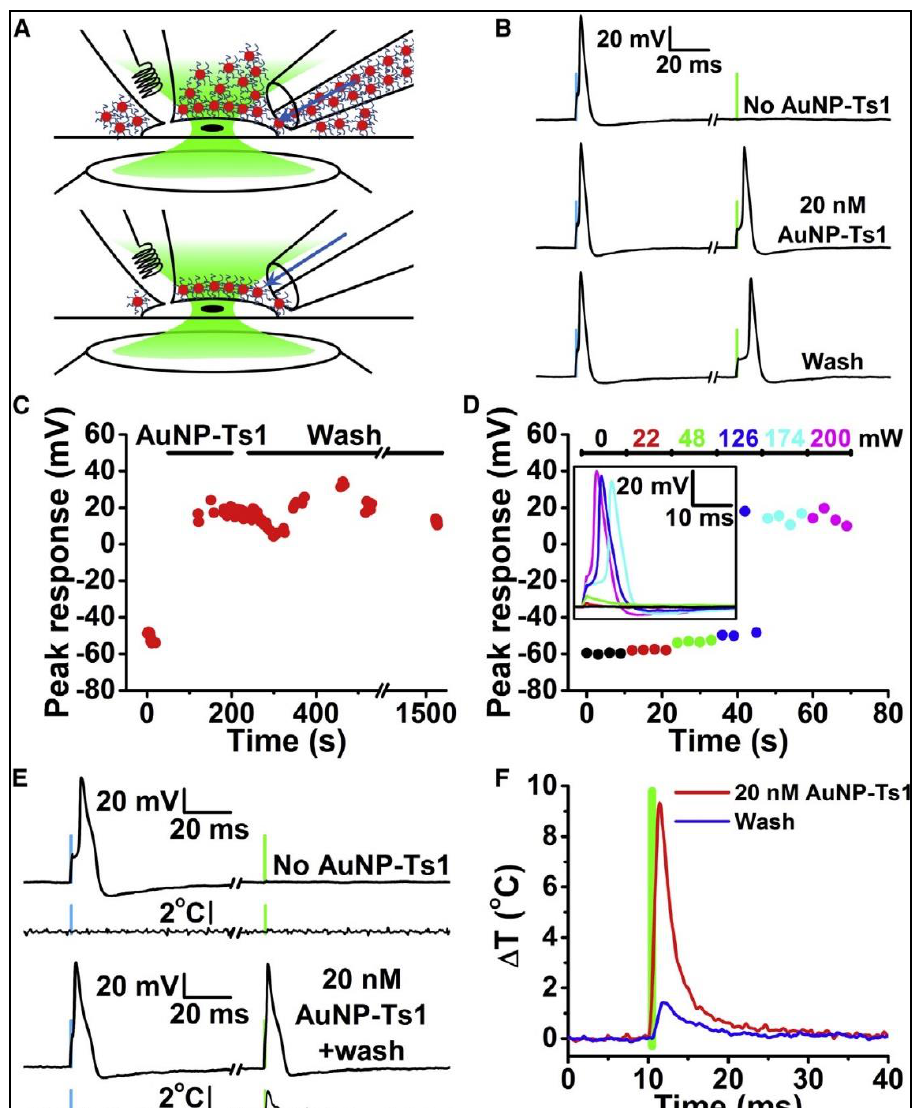
Figure 8. Optical stimulation of DRG neurons with AuNP-Ts1. ( A ) The same procedure used with non-functionalized AuNPs could not wash AuNP-Ts1 off of the cell. ( B ) At first, DRG neurons responded only to electrical stimuli (blue bars: 500 pA, 1 ms), but adding AuNP-Ts1 made the neurons sensitive to optical stimuli (green bars: 174 mW, 532 nm, 1 ms). ( C ) Even after 20 min of continual washing, AuNP-Ts1-labeled neurons were still optically sensitive. ( D ) Increasing the laser power increased cell depolarization. As a result, action potentials were triggered when the cell’s threshold voltage was reached. 174 mW was the required voltage to reliably stimulate this particular neuron. Inset: sample traces for each laser power. ( E ) Without AuNP-Ts1 (top 2 traces), no temperature changes were seen 2 mm away from a DRG cell during both electrical (blue bar) and optical (green bar) stimulation. However, when AuNP-Ts1 were added and excess nanoparticles were washed away (bottom 2 traces), optical stimulation was able to measurably increase the temperature. Temperature traces are single recordings with noise subtraction and are filtered at 1 kHz. ( F ) When nanoparticles were in the bulk solution (before washing), a significant temperature change was seen. After active perfusion washing, only the nanoparticles tightly bound to the surface were left. The cell was still optically excitable, but the temperature change 2 mm from the cell decreased dramatically (Green bar shows the optical stimulus). Reproduced with permission from [38]. Elsevier, 2015.